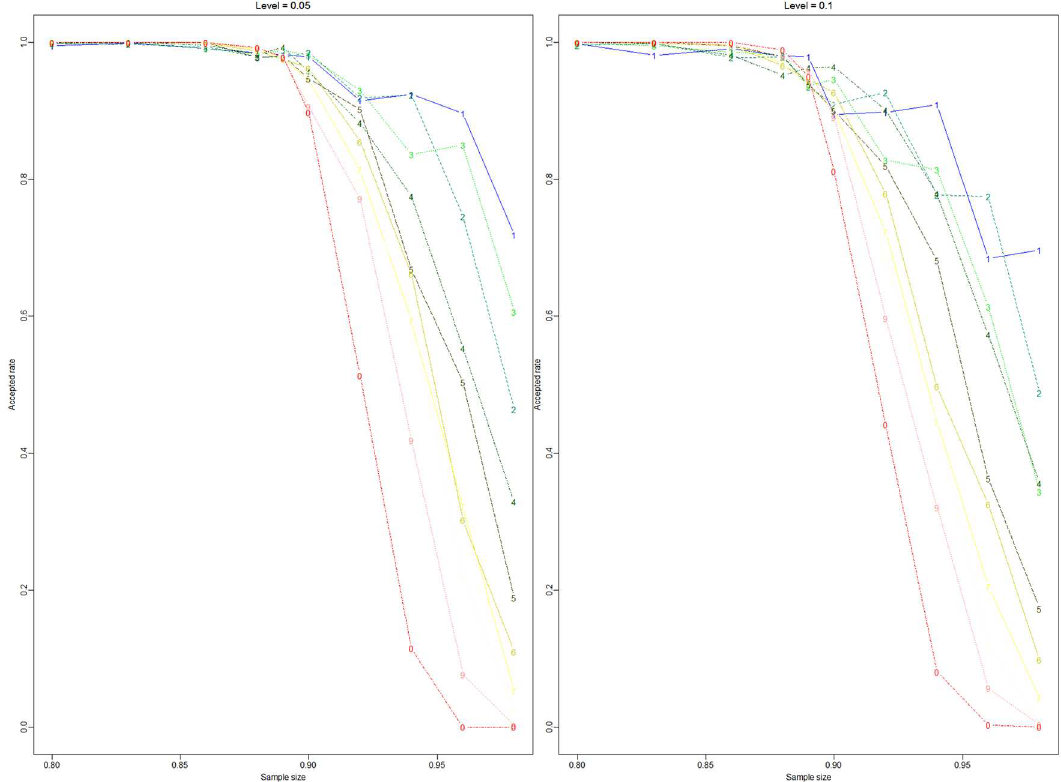
Fig 3. Test H 0 : Ψ 1, A ( t ) (cid:21) Ψ 0 vs H 1 : Ψ 1, A ( t ) < Ψ 0 . Numbers 1, 2, 3, 4, 5, 6, 7, 8, 9, and 0 are across to the sample size 10, 15, 20, 30, 50, 60, 80, 100, 150, and 300, respectively. The x-coordinate is the value of Ψ 0 , and the y-coordinate is the accepted rate. The level of significance in the left panel is 0.05, and the level of significance in the right panel is 0.1.